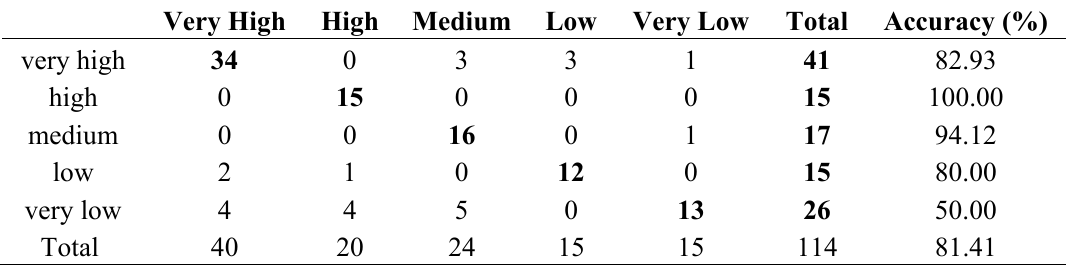
Table 6. Confusion matrix in the Dano study